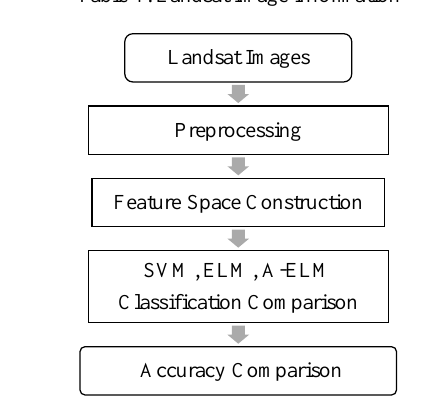
Figure 2. Main experimental procedure